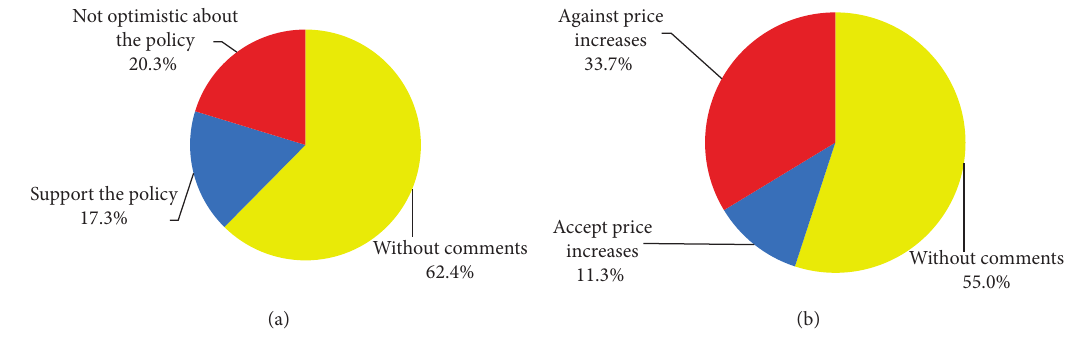
Figure 8: Different opinions in (a) GCPN and (b)